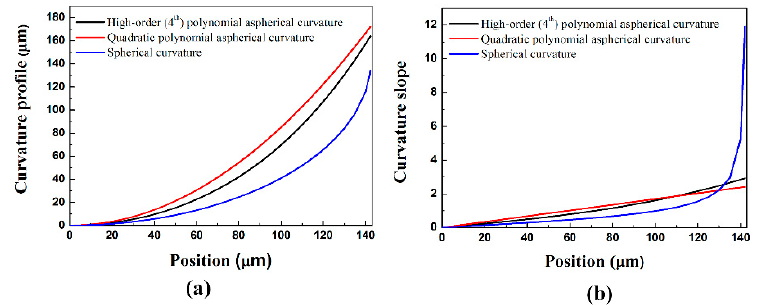
Figure 4. ( a ) Positional curvature profiles and ( b ) positional curvature slopes for the low- ∆ n LC GRIN lens arrays with spherical, quadratic polynomial aspherical, and high-order (fourth-order) polynomial aspherical curvatures.